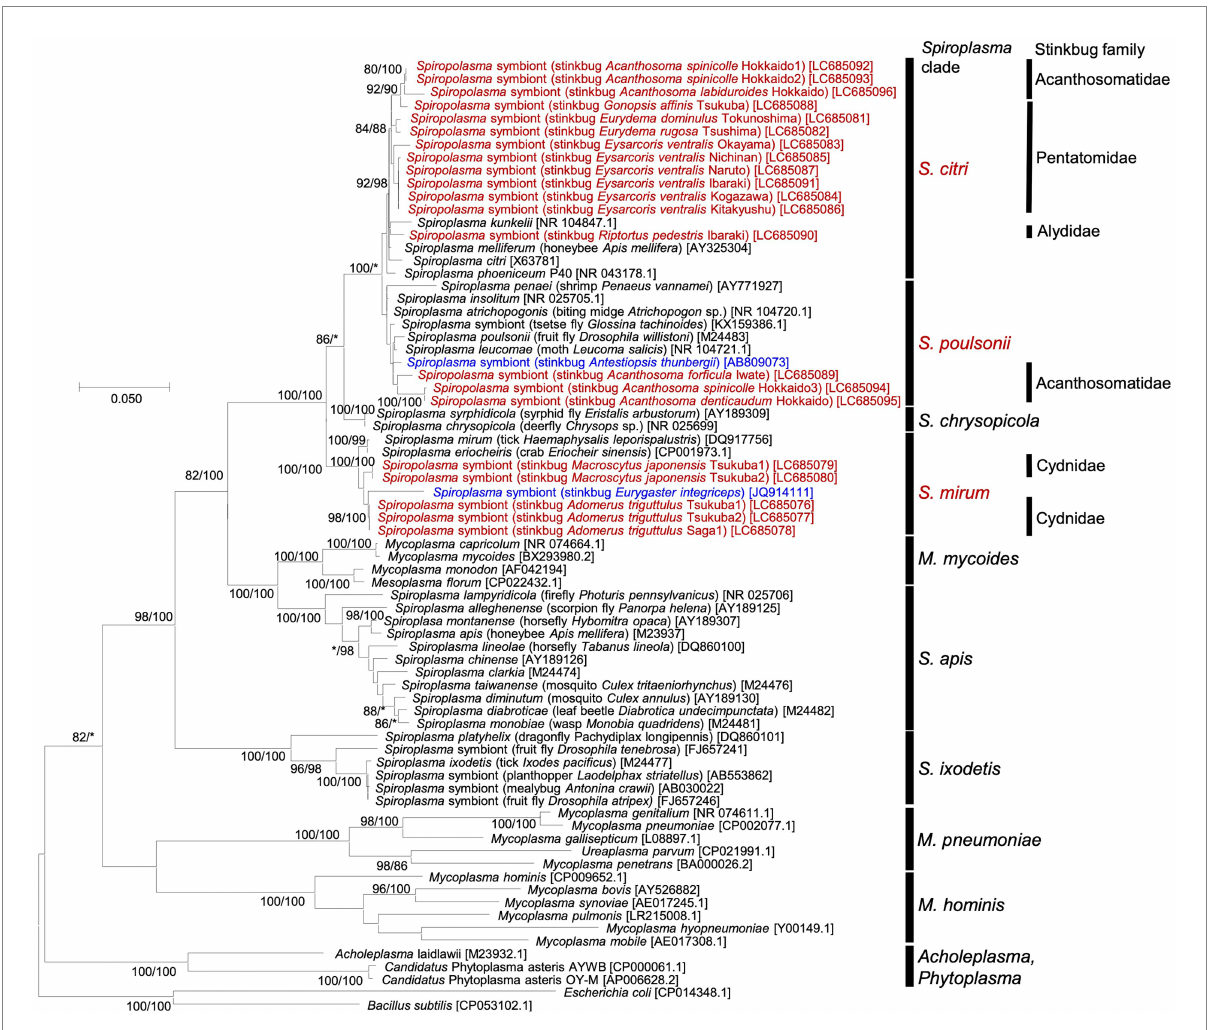
FIGURE 1 Phylogenic relationship of Spiroplasma symbionts detected from diverse stinkbugs based on 16S rRNA gene sequences. A maximum-likelihood phylogeny inferred from 1,632 aligned nucleotide sites is shown. Bootstrap support probabilities were obtained from 1,000 resamplings, of which the values of 80% or higher are shown at the nodes in the order of maximum likelihood/neighbor joining. Asterisks indicate support values lower than 80%. For each bacterial sequence, host-related information in parentheses and accession number in brackets are shown. The Spiroplasma sequences detected from stinkbugs in this study are highlighted in red, the Spiroplasma sequences detected from stinkbugs in previous studies (Matsuura et al., 2014; Amiri et al., 2020) are highlighted in blue, and the other sequences of Spiroplasma and allies retrieved from the databases are shown in black. The major Spiroplasma clades are depicted on the right side according to previously published papers (Paredes et al., 2015; Ballinger and Perlman, 2019) and the MolliGen database (Barré et al., 2004). On the right side, host stinkbug families for the Spiroplasma positive samples are also